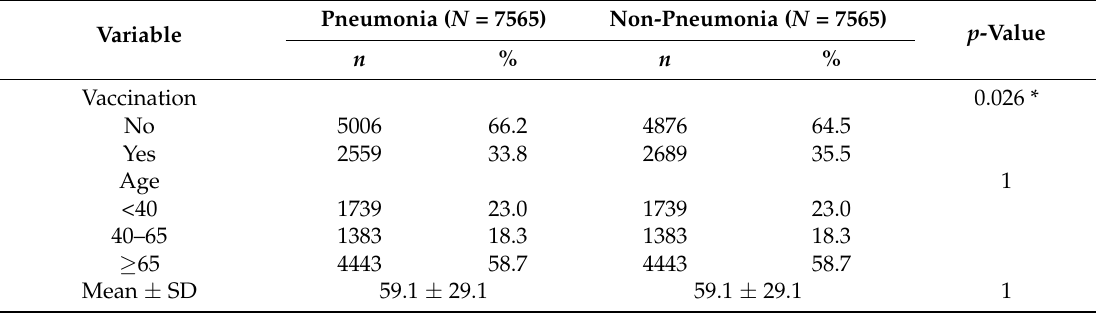
Table 1. Demographic characteristics of pneumonia and